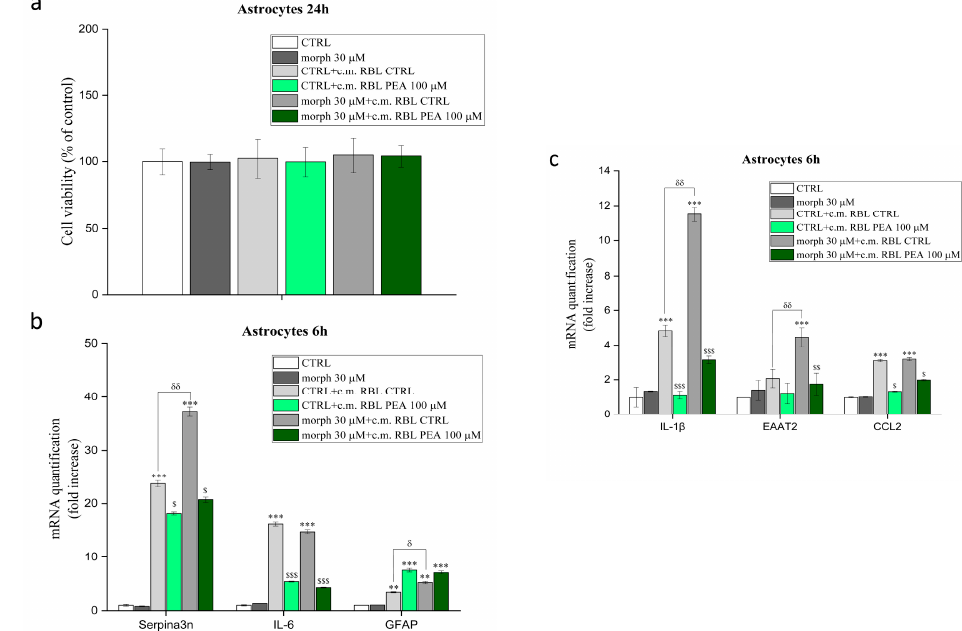
Figure 5. Effect of control and PEA pre-treated MC medium on astrocyte viability and gene expression. ( a ) MTT of astrocytes treated with 30 μ M morphine (48 h) and conditioned medium (c.m.) from RBL-2H3 (24 h) stimulated with DNP-BSA (24 h) and pre-treated or not (control) with 100 μ M PEA. Control condition was arbitrarily set at 100, values are expressed as the mean ± S.E.M. of two exper- iments. ( b , c ) RT-PCR of astrocytes treated with 30 μ M morphine (48 h) and conditioned medium (c.m.) from RBL-2H3 (6 h) stimulated with DNP-BSA (24 h) and pre-treated or not (control) with 100 μ M PEA. Control condition was arbitrarily set at 1, values are expressed as the mean ± S.E.M. of three experiments. DNP-BSA was used at a final concentration of 625 ng/mL in all experiments. ** p < 0.01; *** p < 0.001 vs. control astrocytes. $ p < 0.05; $$ p < 0.01; $$$ p < 0.001 vs astrocytes + c.m. RBL- 2H3 CTRL. δ p < 0.05; δδ p < 0.01 morphine astrocytes + c.m. RBL-2H3 CTRL vs. control astrocytes + c.m. RBL-2H3 CTRL.